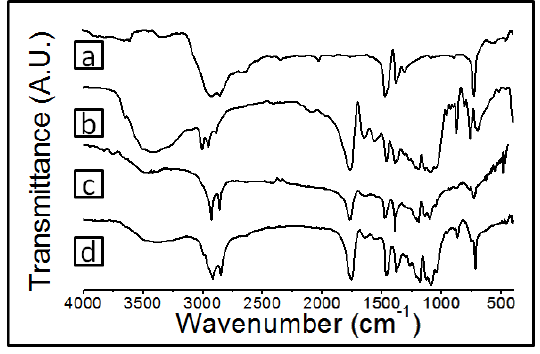
Figure 4. FTIR spectra of ( a ) PE, ( b ) Ch-PLA, ( c ) H3 film and ( d ) I3